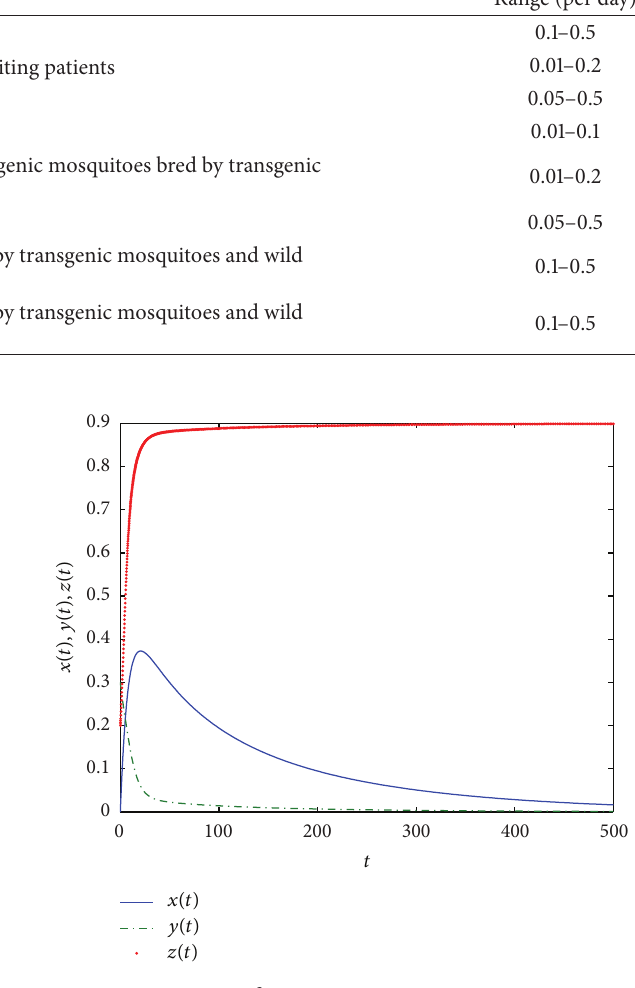
Figure 4: Parameters: 𝛽 = 0.2, 𝛼 = 0.1, 𝛾 = 0.02, 𝜇 = 0.05, 𝜔 = = 0.1, and 𝛿 = 0.5 0.05, 𝑐 = 0.1, 𝛿 1 2